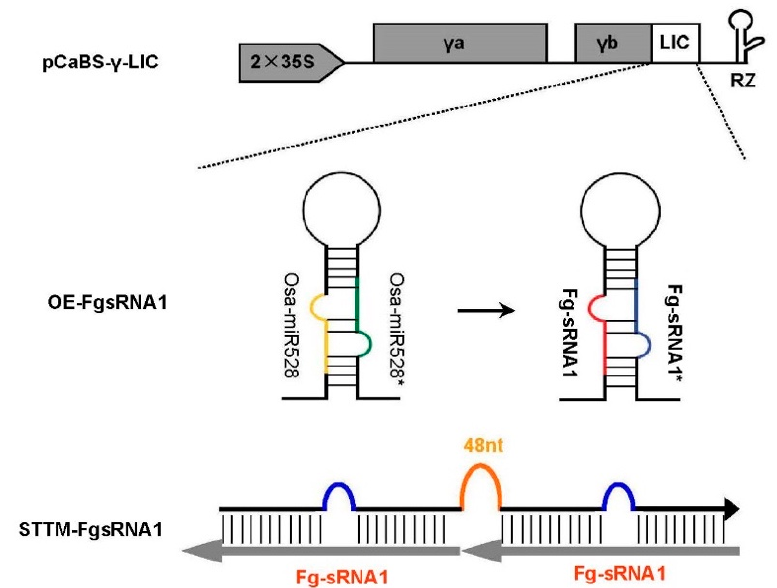
Figure 3. Schematic diagram of integrating BSMV- γ b vector and Osa-miR528 precursor harboring Fg-sRNA1 or STTM sequences. Modified BSMV- γ b vector (pCaBS- γ -LIC) was shown in this figure. Osa-miR528 precursor harboring Fg-sRNA1 or STTM sequences can be cloned into pCaBS- γ -LIC derivatives by the LIC reaction. OE-FgsRNA1 structure contained an Osa-miR528 precursor backbone, but Osa-miR528 and Osa-miR528 * were changed to Fg-sRNA1 and Fg-sRNA1 * . STTM-FgsRNA1 structure contained two tandem target mimics separated by a 48 nt imperfect stem-loop linker.